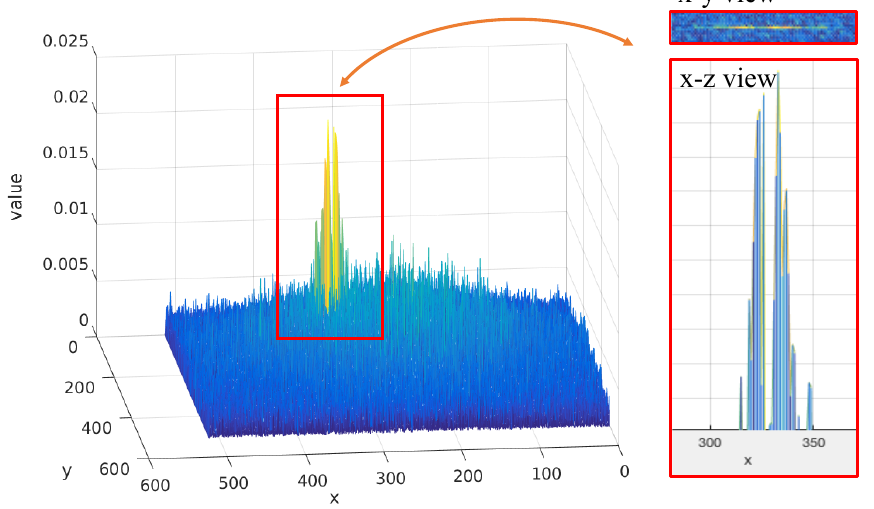
Figure 2. An example of a translation phase shift diagram in a multi-depth (more than two depths)